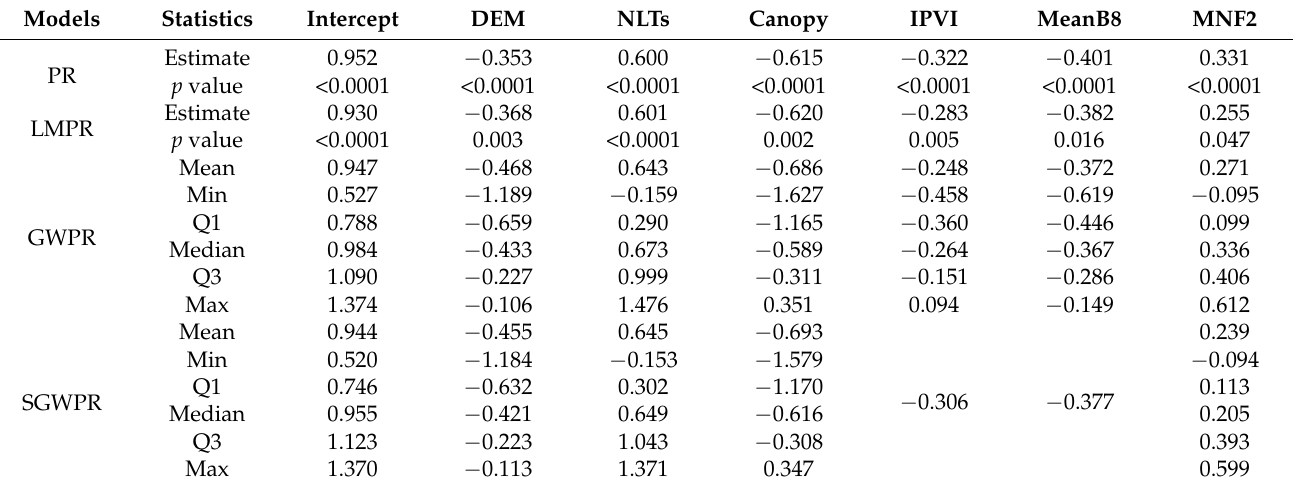
Table 3. Global and local model coefficient estimates.